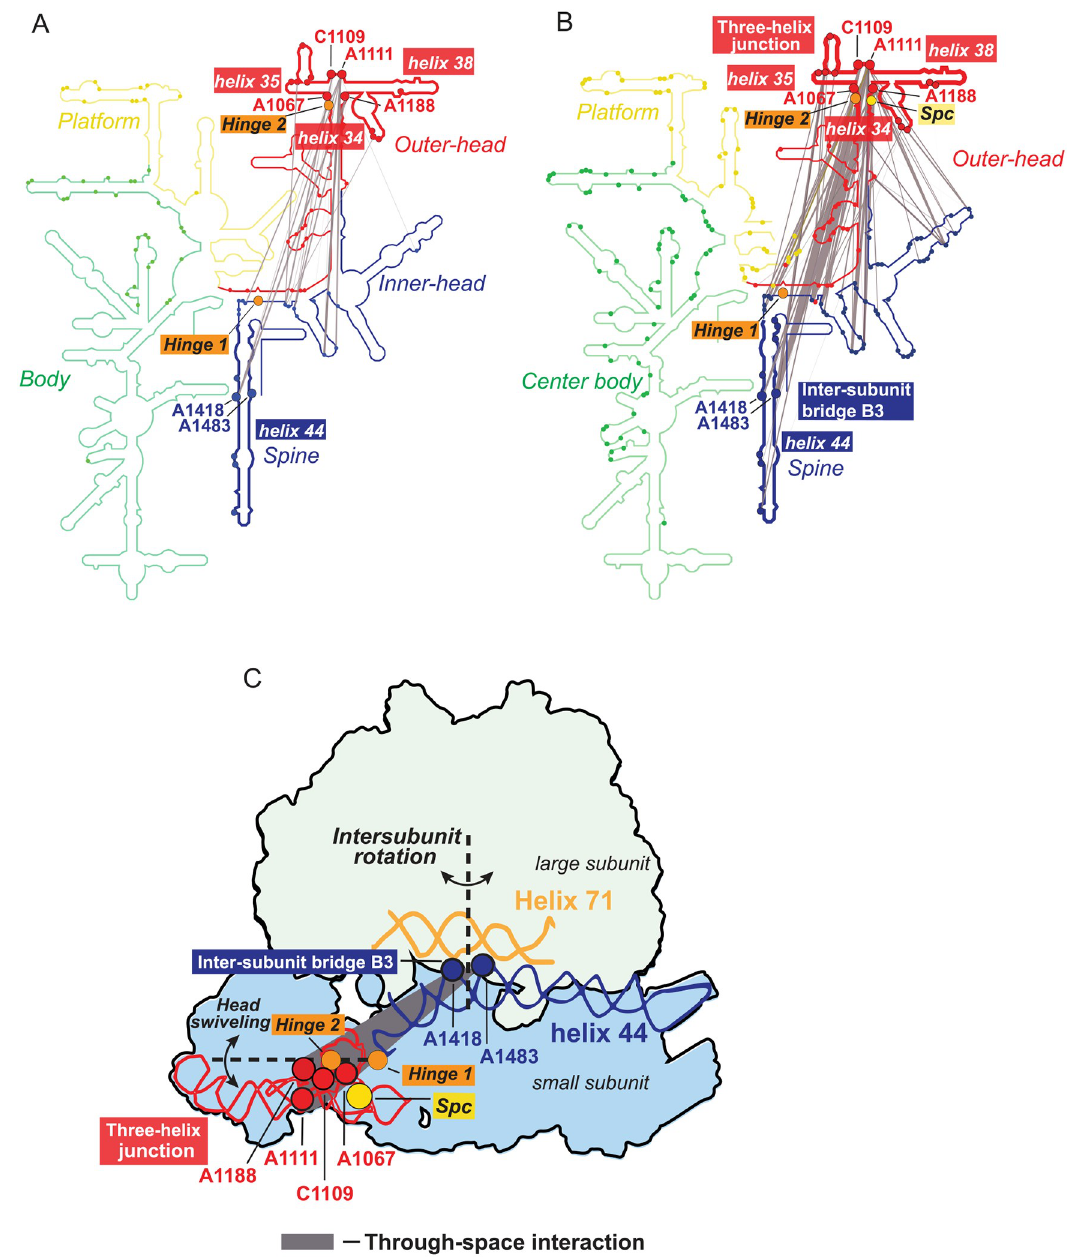
Fig 5. Cross-community interactions strengthened upon Spc binding. (A, B) Cross-community correlations connecting the outer- head (red) and inner-head and spine (blue) communities are shown as grey lines on secondary structure diagrams for experiments performed (A) without and (B) with Spc treatment. The strongest cross-community interactions link nodes in the outer-head domain at the h34-h35-h38 3-helix junction to nodes in helix 44 of the inner-head and spine domain. Orange spheres indicate the two hinges that allow head domain swiveling [10]. (C) Cross-community interactions visualized with respect to the three- dimensional structure of bacterial ribosome. The two dashed lines mark the axes for head swiveling (passing through hinges 1 and 2) and for intersubunit rotation (at bridge B3). Bridge B3 links helix 44 of 30S rRNA with helix 71 of the 23S rRNA of the large subunit. rRNA, ribosomal RNA; Spc, spectinomycin.